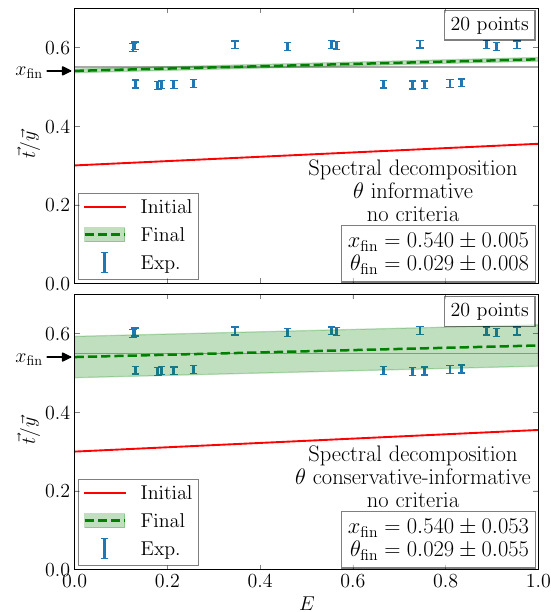
Figure 6. Uncertainty propagation in the informative (top) and conservative-informative (bottom) spectral methods.